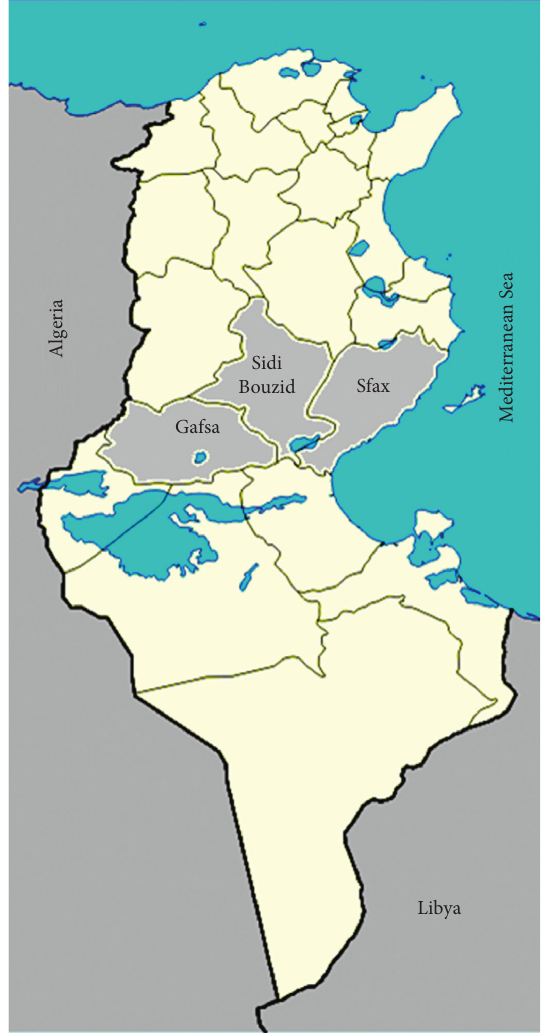
Figure 1: The collection areas for the investigated pistachio